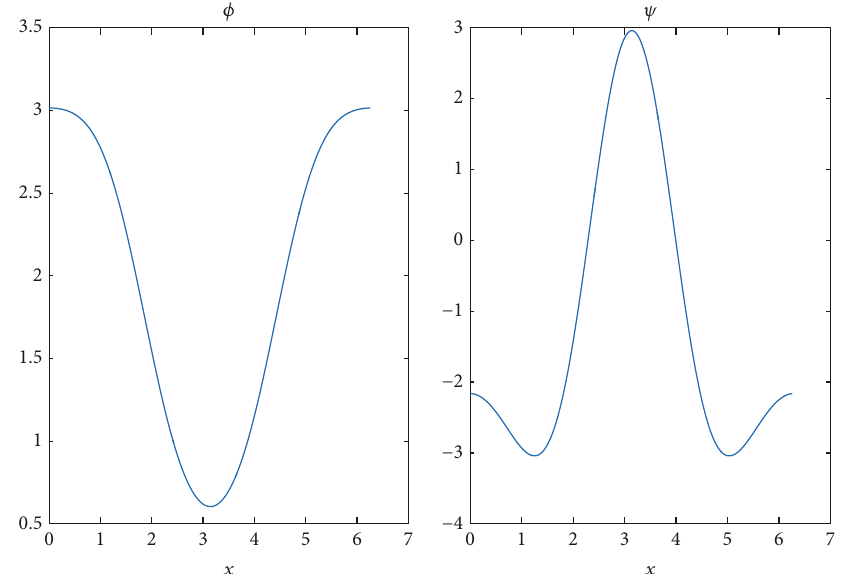
Figure 8: Approximations of the functions 𝜙, 𝜓 in the travelling wave solution (39) with 6 Newton’s iterations. The model’s parameters are 𝛼 = 𝛽 = 𝛾 = 1 , 𝑤 = 2 , and wave speed 𝑐 = 2 and the fundamental period is 𝐿 ≈ 6.28